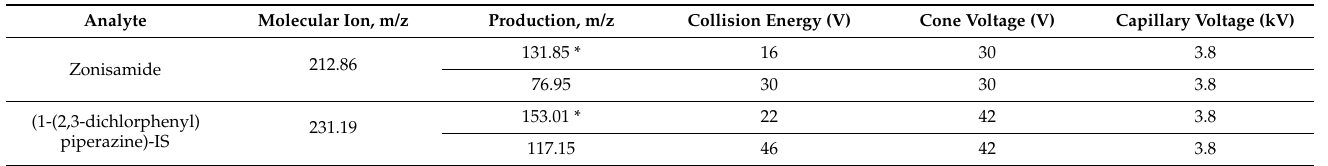
Table 1. MRM transitions and corresponding MS/MS tune